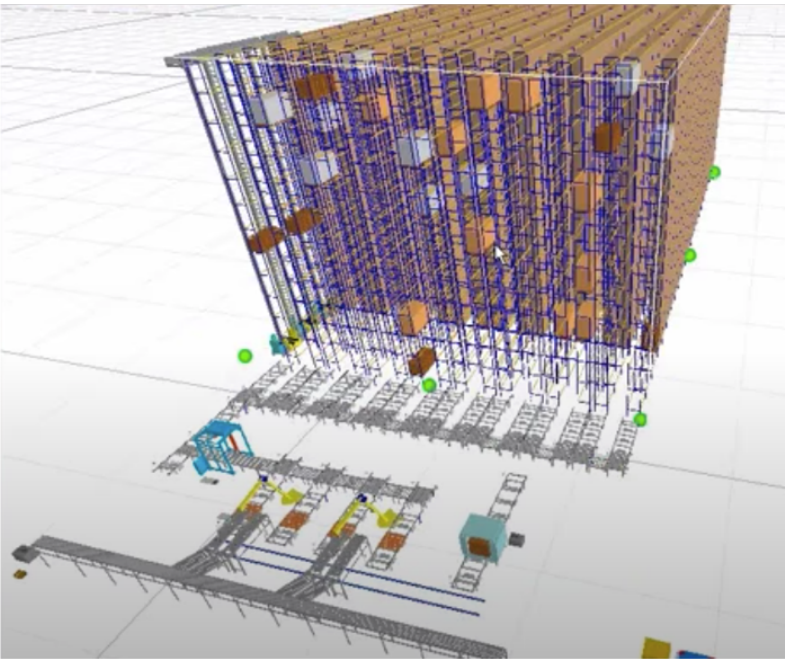
Figure 11. Reference warehouse for case no.1: using the approach described in Section 2.1, the goal is to reproduce a virtual replica to be used as an early prototype of the physical warehouse.